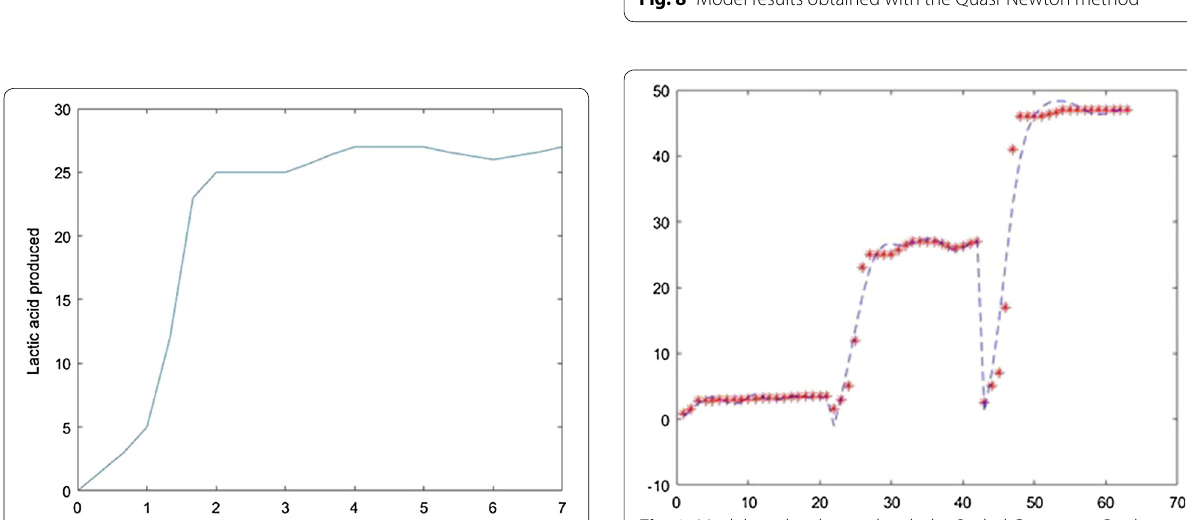
Fig. 9 Model results obtained with the Scaled Conjugate Gradient method